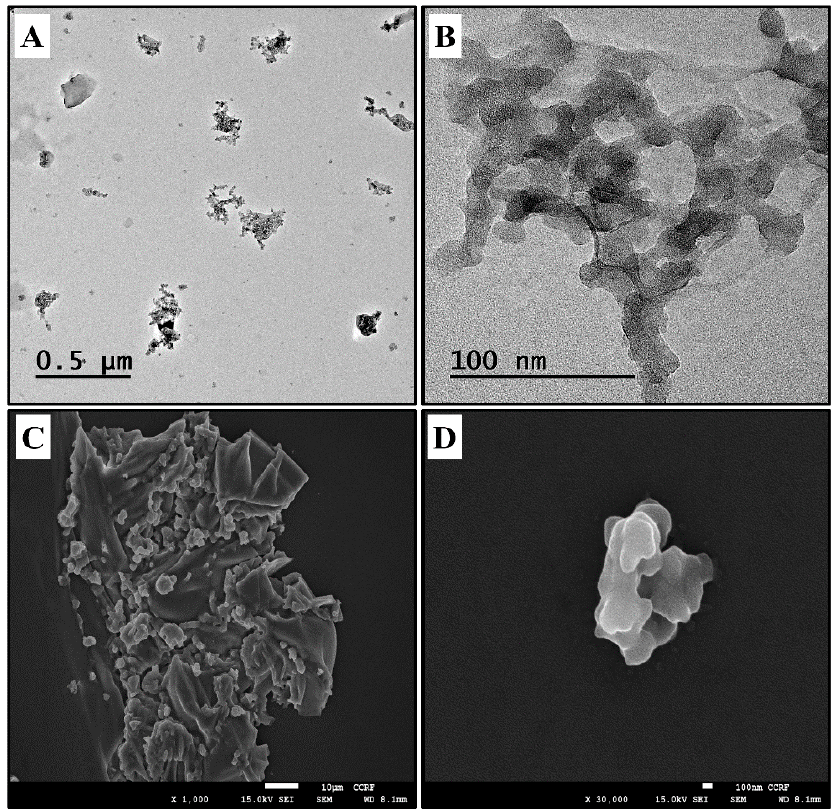
Figure 1. Morphology of SiONPs. ( A , B ) TEM images of SiONPs. ( C , D ) SEM images of SiONPs. 2.2. Effects of SiONPs on Inflammatory Cell Counts in the bronchoalveolar lavage fluid (BALF) from Vehicle- and LPS-Treated Mice